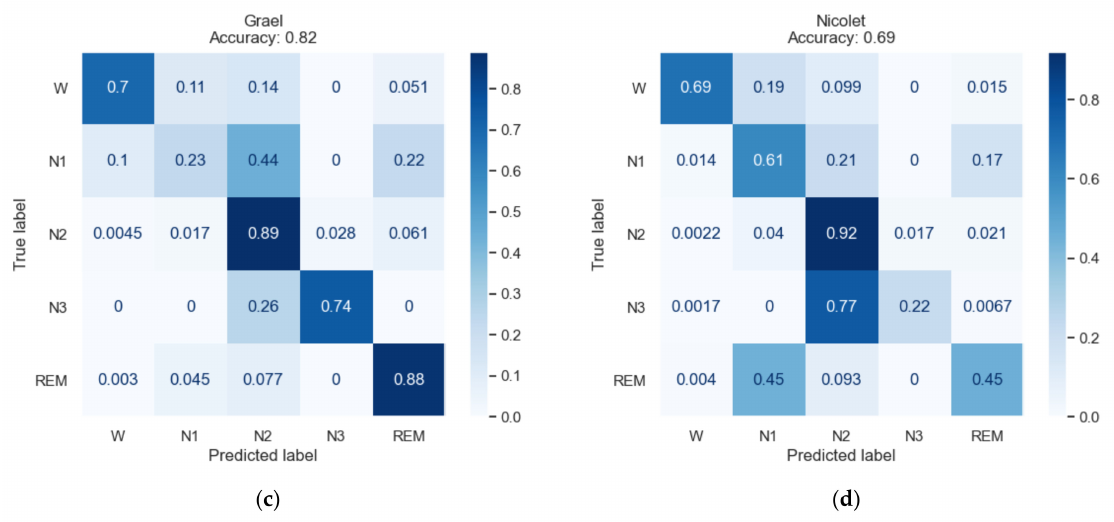
Figure 4. Classification results for the Clinical dataset. ( a ) Confusion matrix of the whole dataset split; ( b ) confusion matrix of Alice split; ( c ) confusion matrix of Grael split; ( d ) confusion matrix of Nicolet